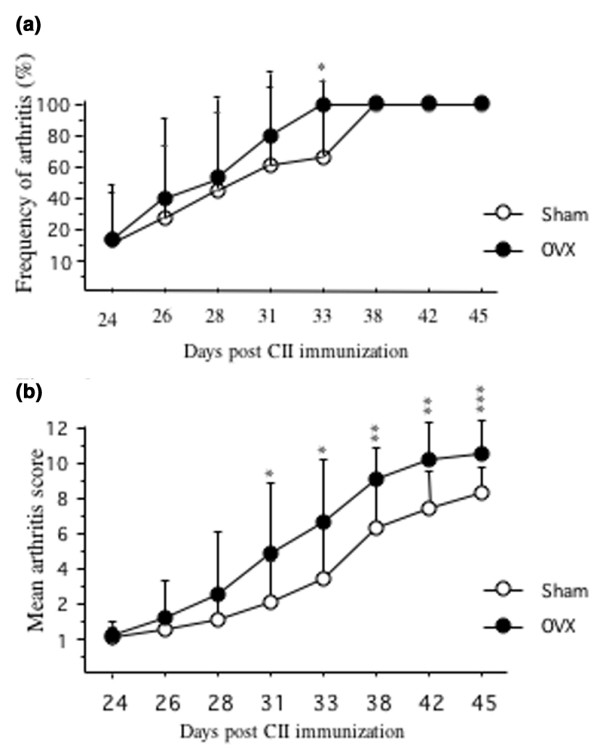
Mice after ovariectomy (OVX) displayed a significantly more severe disease than sham-operated mice. (a) The mice were observed twice weekly for frequency of arthritis. They were considered arthritic when they displayed signs of arthritis in one joint for two consecutive assessments, or arthritis in more than one joint. (b) Severity of arthritis was evaluated twice weekly. Severity was graded 1 to 3 in each paw (maximum 12 points per mouse). Open circles, sham (n = 18); filled circles, ovariectomy (n = 15). *P < 0.05; **P < 0.01; ***P < 0.001. CII, type II collagen.